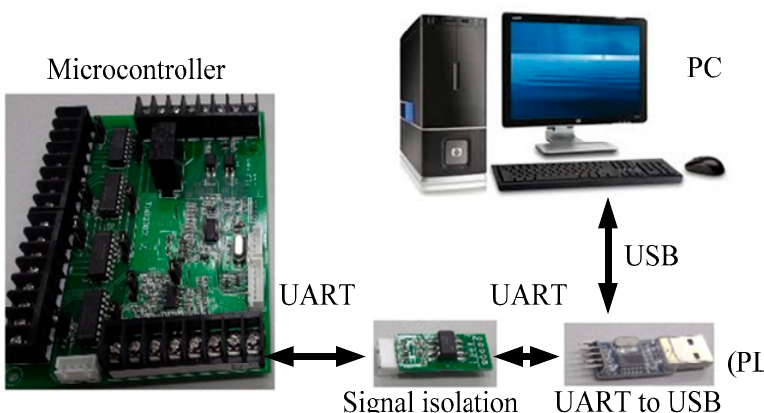
Figure 13. Signal conversion diagram.